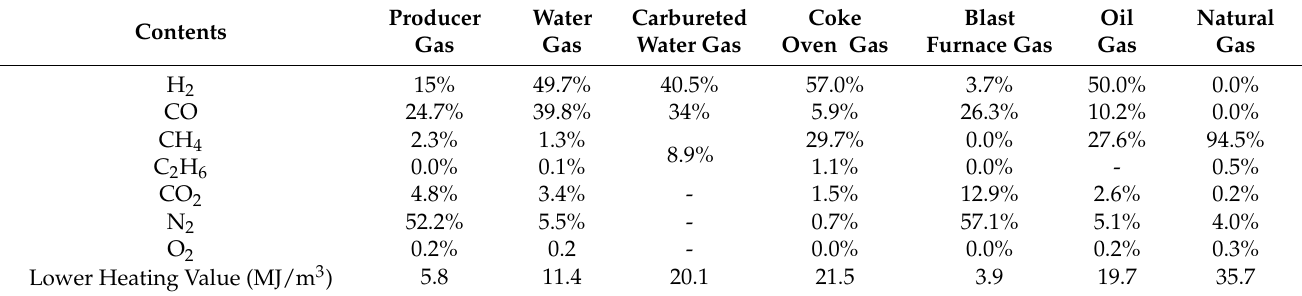
Table 3. Properties of selected manufactured gases and natural